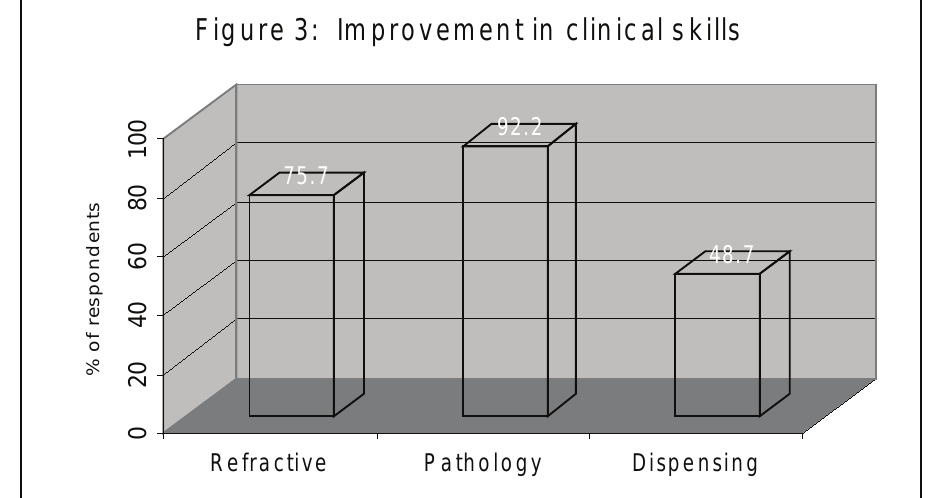
trend in Figure 3.